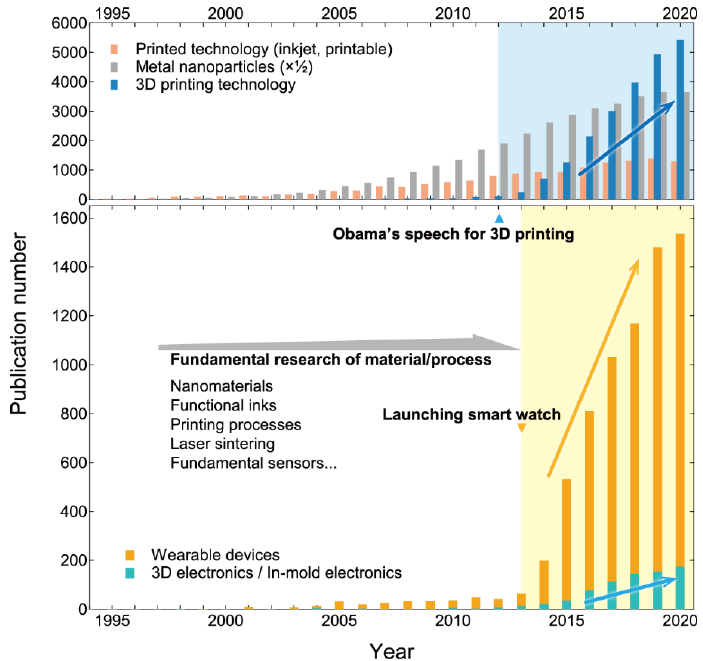
Figure 1. A change in publication numbers of the recent research topics “wearable devices” and “3D electronics/In-mold electronics”, and their related research areas “printed technology, metal nanoparticles, and 3D printing technology”.